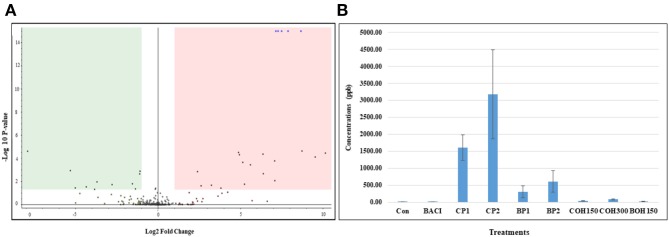
(A) Volcano plot generated by differential analysis and showing a representative metabolomics profile of blood plasma of chickens treated with control and cranberry 2%. Volcano plot of fold changes (x-axis) and their associated log10 transformed P-values (y-axis) for phenolic compounds analyzed by LC-MS. The green and pink area indicated downregulation and upregulation, respectively. The blue dots in the upregulated area were identified as the quinic acid. (B) Quinic acid level in blood plasma of chicken fed with or without berry products. Data represent means ± SEM of seven replicates/treatment (two birds/pen = 14 birds/treatment).